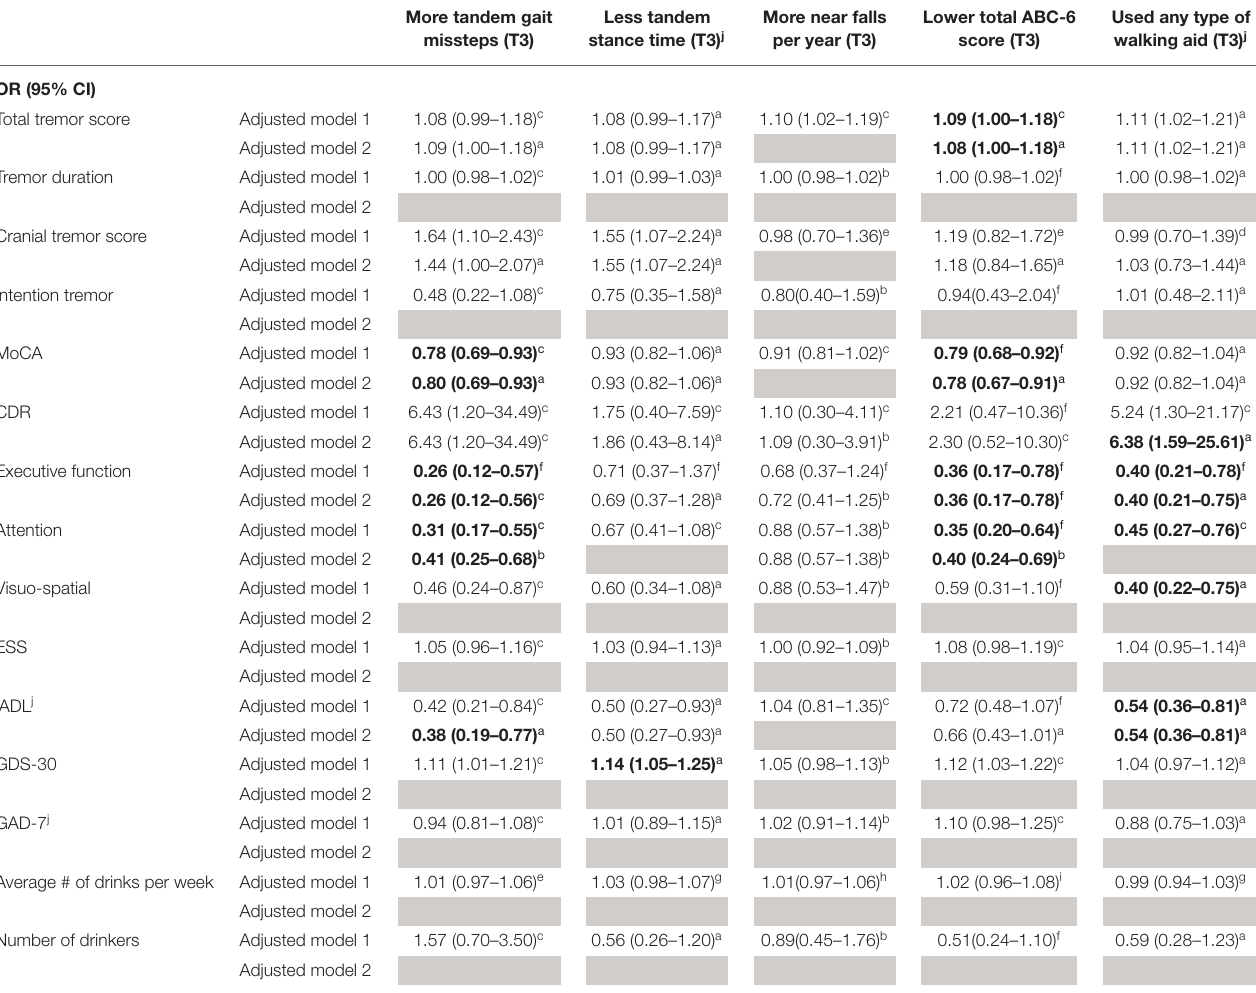
TABLE 4A | Adjusted logistic regression models: Baseline characteristics as predictors of T3 gait and balance